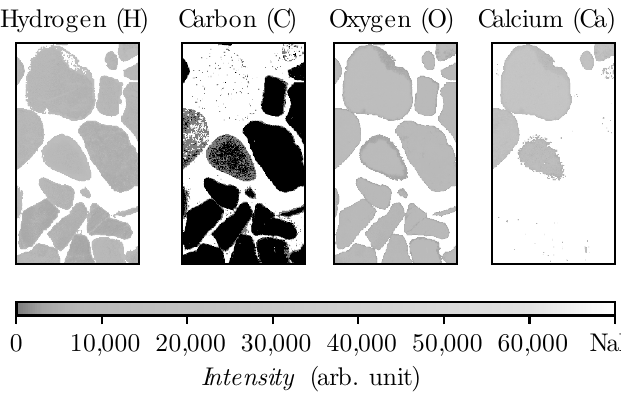
Figure 5. Gravel heatmap after epoxy removal from sample type (1) in spectral range 525–940 nm.